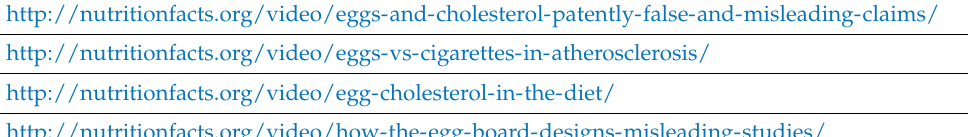
Table 1. Online videos about egg industry